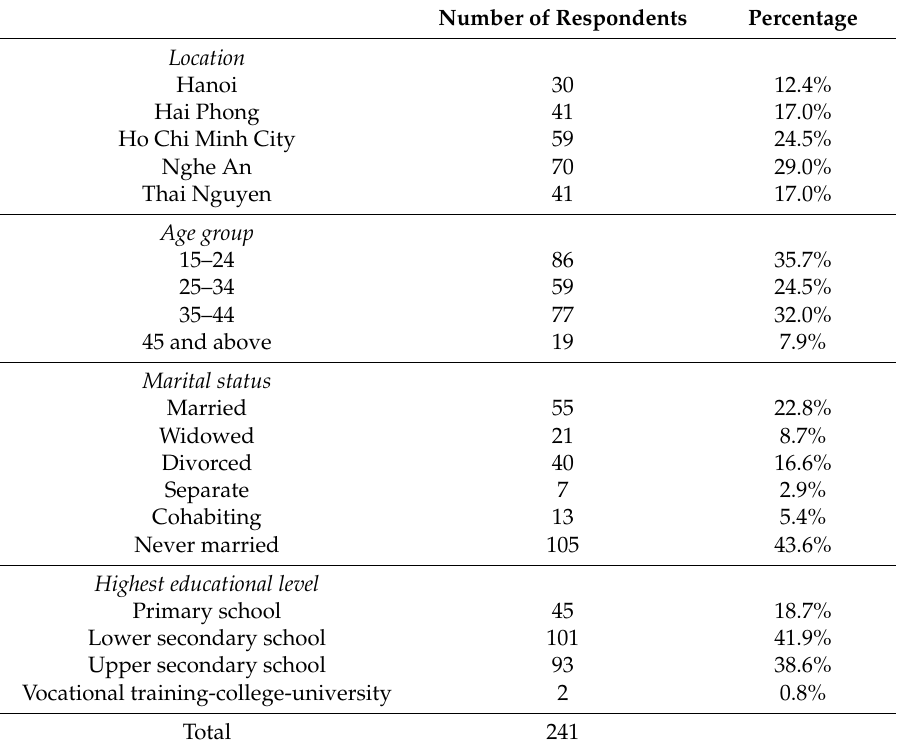
Table 2. Background characteristics of survey respondents.